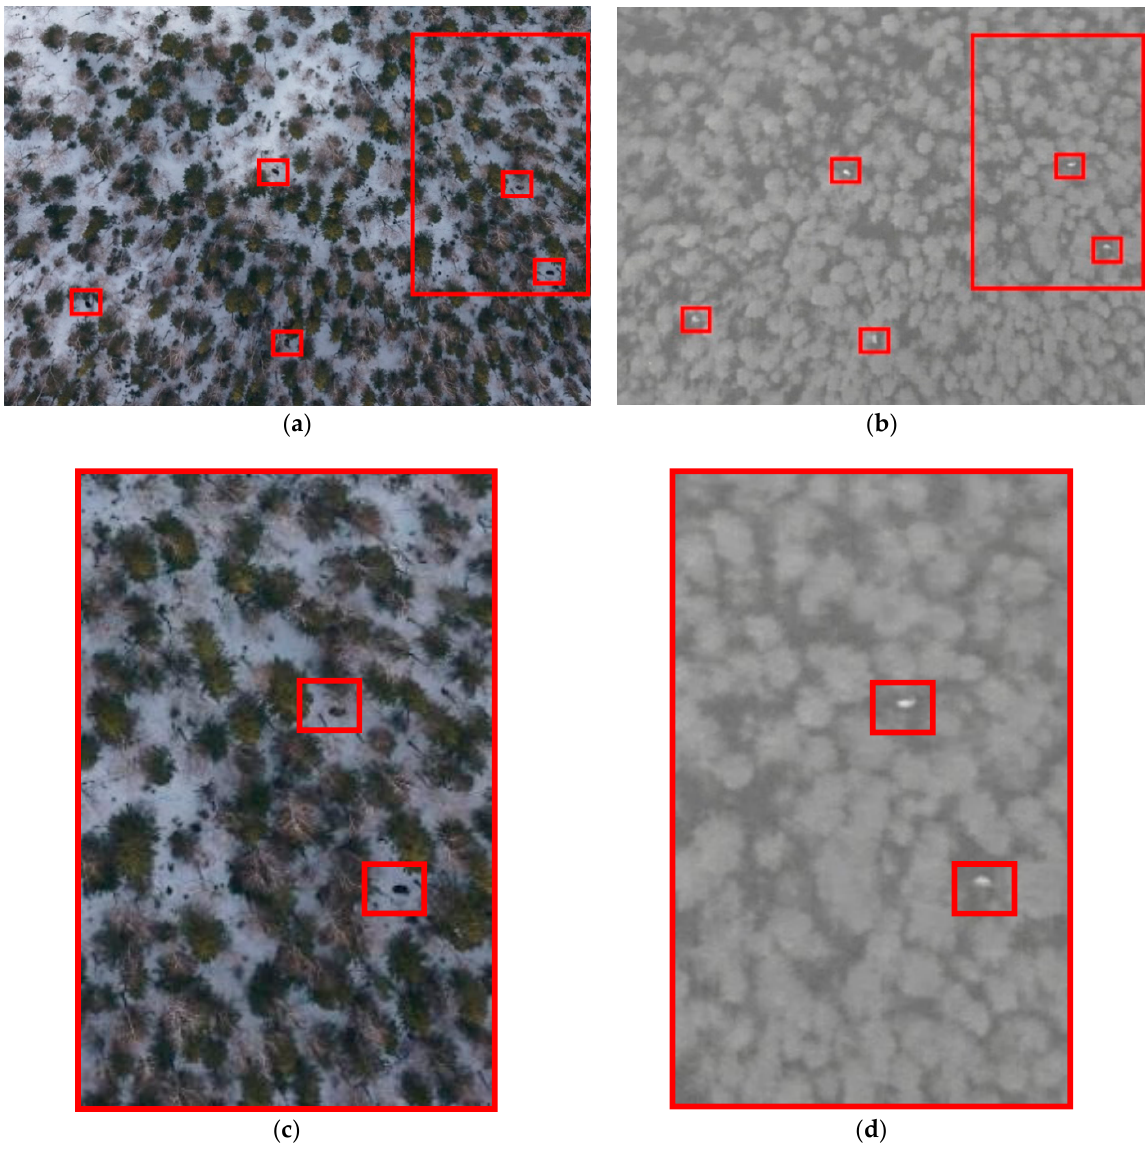
Figure 7. Comparison of RGB and infrared images of Group 2: ( a ) part of the RGB image corresponding to the capture of the infrared image; ( b ) the infrared image corresponding to image ( a ); ( c ) and ( d ) are zoomed-in images of ( a ) and ( b ), respectively.